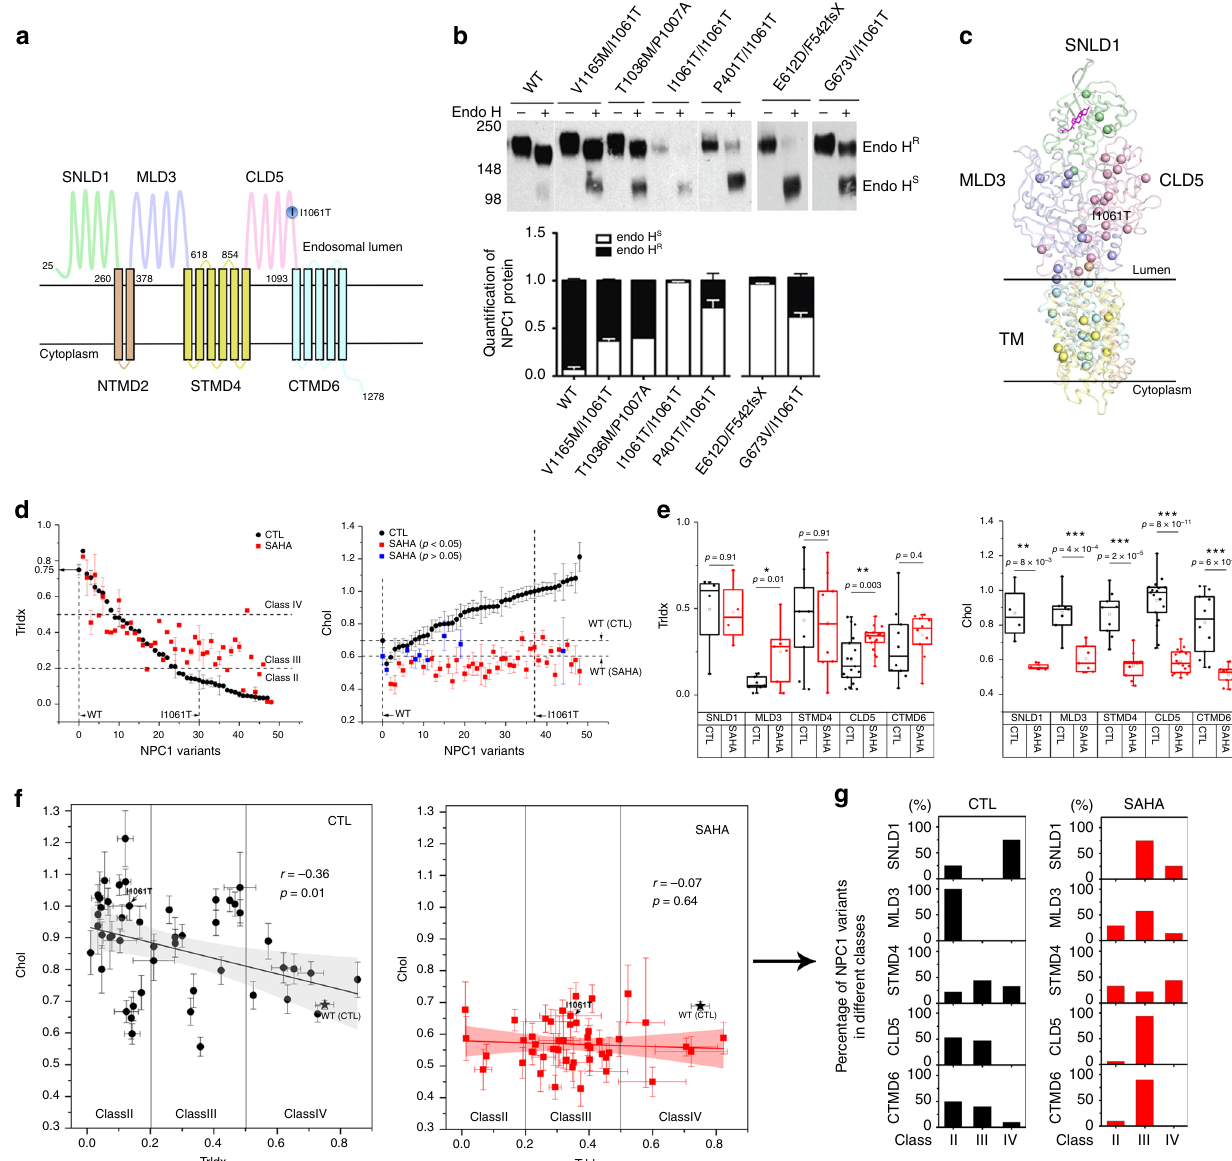
Fig. 1 Response of NPC1 variants to SAHA. a Schematic representation of domains in NPC1 (sterol-binding luminal N-terminal domain 1 (SNLD1), N- terminal transmembrane domain 2 (NTMD2), middle luminal domain 3 (MLD3), sterol-sensing transmembrane domain 4 (STMD4), C-terminal luminal domain 5 (CLD5), C-terminal transmembrane domain 6 (CTMD6)). b (Upper panel) Traf fi cking of NPC1 variants from the ER (Endo H sensitive (Endo H S )) to post-ER LE/LY compartments (Endo H resistant (Endo H R )) glycoforms in wild-type (WT) and NPC1 patient fi broblasts. (Bottom panel) Fraction of total of NPC1 in Endo H R (black) and Endo H S (white) glycoforms (mean ± s.d.). c NPC1 variants are mapped as balls on the C-alpha position in the NPC1 structure 25,29 . The cholesterol molecule is shown in magenta 25,35 . d (Left panel) Traf fi cking index (TrIdx) of 48 NPC1 variants in the absence (black circles as control (CTL)) or presence of SAHA (red squares). WT, I1061T variants are indicated by vertical dash lines and traf fi cking classes (II, III, IV) by horizontal dash lines. (Right panel) Cholesterol (Chol) homeostasis of 48 NPC1 variants in the absence (black circles as control (CTL)) or presence of SAHA (red squares for p -value < 0.05; blue squares for p -value > 0.05; student ’ s two tailed t -test) 21 . WT and I1061T variants are indicated by vertical dash lines. Chol of WT in the absence or presence of SAHA highlighted by horizontal dashed lines. Data are presented as mean ± s.e.m. 21 (Source data are provided as a Source Data fi le). e Domain speci fi c response to SAHA. NPC1 variants are clustered into different domains for TrIdx (left panel) and Chol (right panel) comparison (box and whisker plot: box = 25th and 75th, whiskers extend from minimum to maximum of the data; p -value (Student ’ s two tailed t -test)). f Correlation between TrIdx and Chol of NPC1 variants in the absence (left panel) or presence (right panel) of SAHA. Pearson ’ s r and the p - value (ANOVA test) with null hypothesis as the coef fi cient equal to zero is indicated. g Redistribution of different traf fi cking classes in response to SAHA. The percentage of variants in different classes in absence ( f , left panel) or presence ( f , right panel) of SAHA is shown